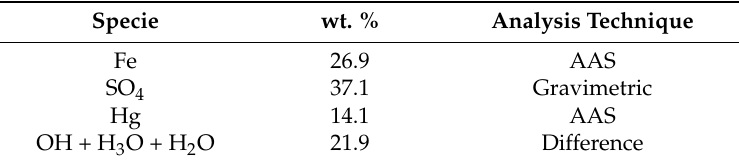
Table 1. Elemental analysis of the obtained products.